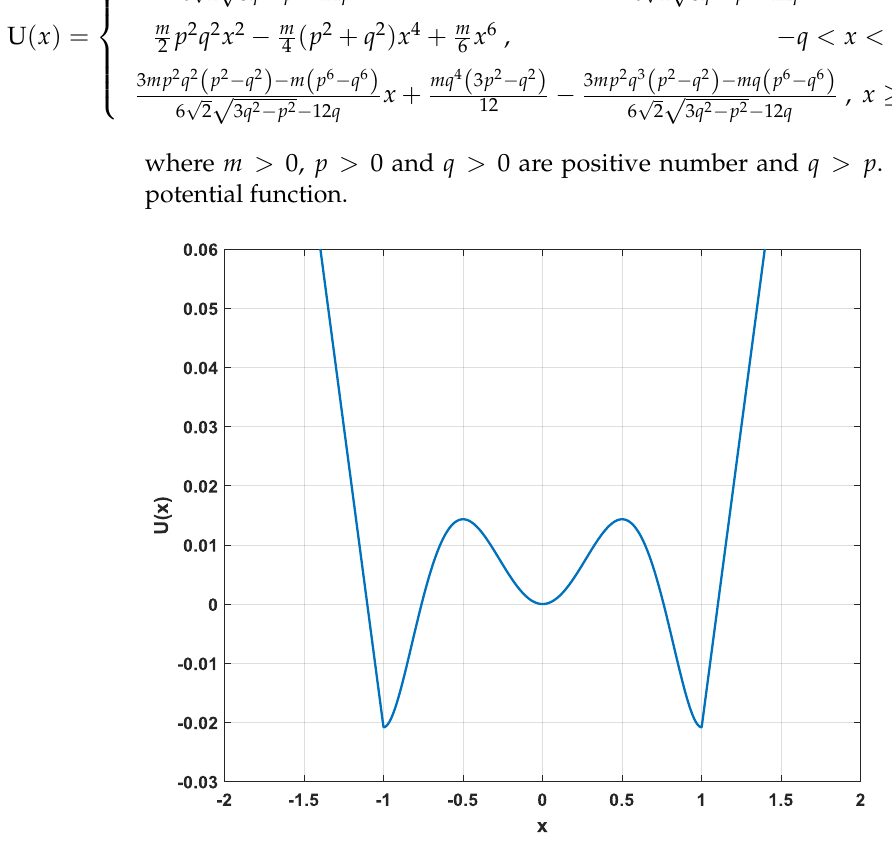
Figure 1. Potential function ( 𝑚 = 1,𝑝 = 0.5,𝑞 = 1 ).